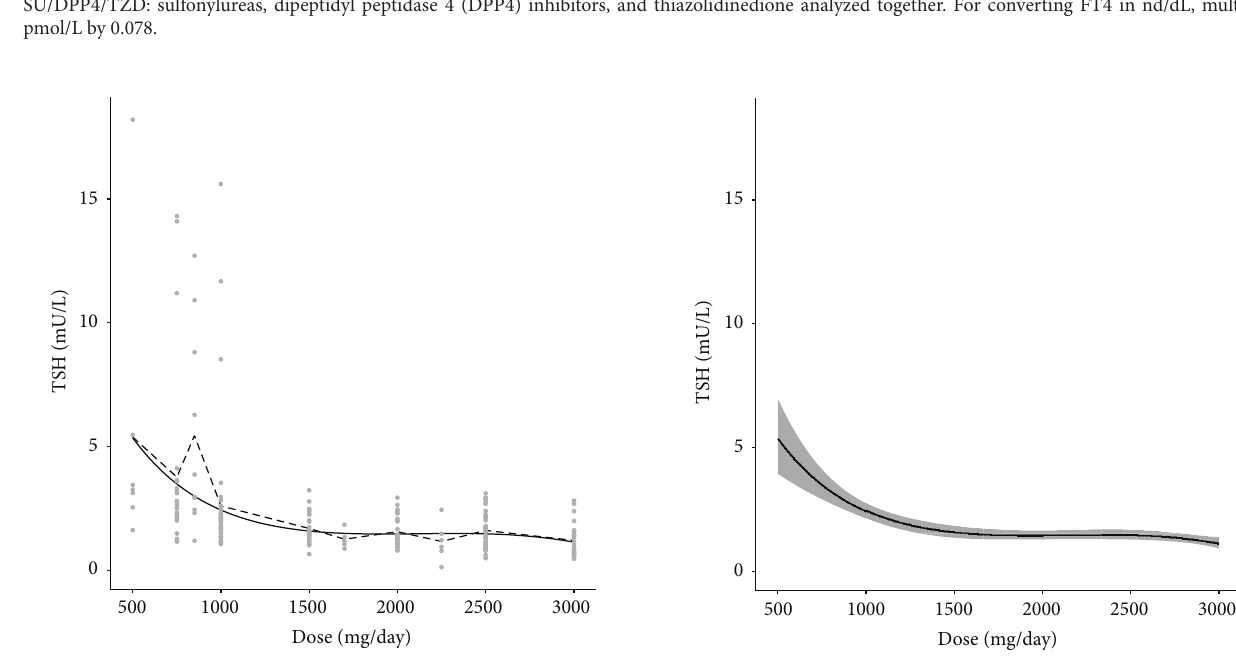
Figure 1: Estimated TSH according to the MTF dose. Comparison between observed and predicted values. Points represent each patient, the dashed line represents the observed average TSH, and the full line represents the estimated average TSH.